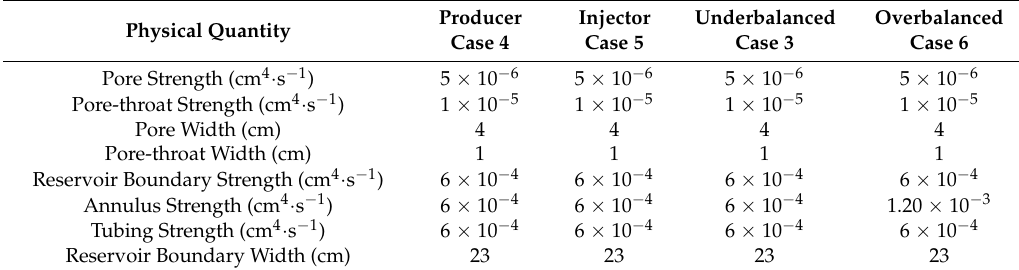
Figure 8. Producer well. ( a ) Streamlines (green) for flow from reservoir to the wellbore obtained by solving the stream function for the integrated system. ( b ) Pressure field obtained by solving the corresponding potential function scaled in units of cm 2 s − 1 (Case 4, Table 1). ( c ) Dynamic bottomhole pressure profiles (along vertical axis in cm 2 s − 1 ) for production well. Central portion of profile (in wellbore) needs to be folded downward to correct for branch cut effect (i.e., bottomhole pressure (BHP) minimum occurs in the wellbore center). Length units are scaled in cm (both x-axis and y-axis). Table 1. Inputs for wellbore